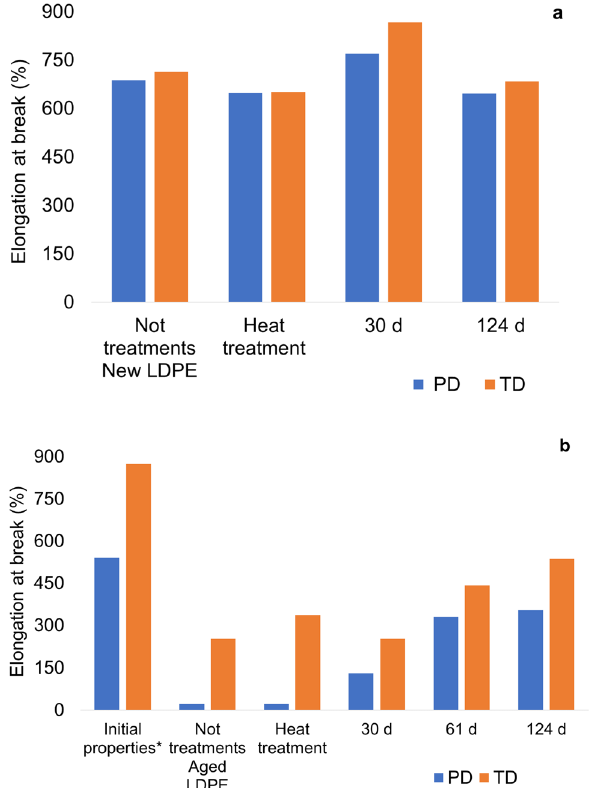
Fig. 4 Percentage of elongation at break in LDPE samples in par- allel direction (PD) and transversal direction (TD). a On new LDPE samples without treatment; with heat treatment during 124 days (heat treatment); and composted samples during 30 days (30d) and 124 days (124d). b On aged LDPE samples. It shows initial proper- ties*; samples without treatments; with heat treatment during 124 days (heat treatment); and composted samples during 30 days (30d) and 124 days (124d). *Initial properties of aged LDPE (used for greenhouse covering) are values obtained from the sheet with technical information of the